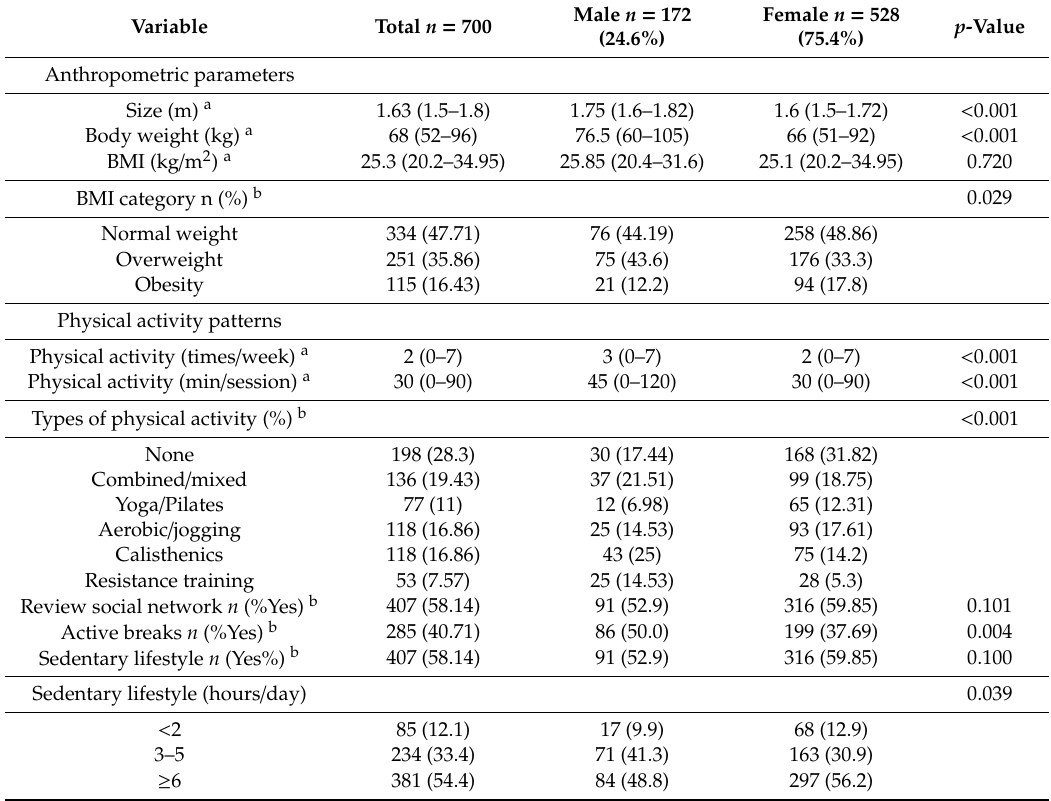
Table 2. Anthropometric and physical characteristics of the study sample.